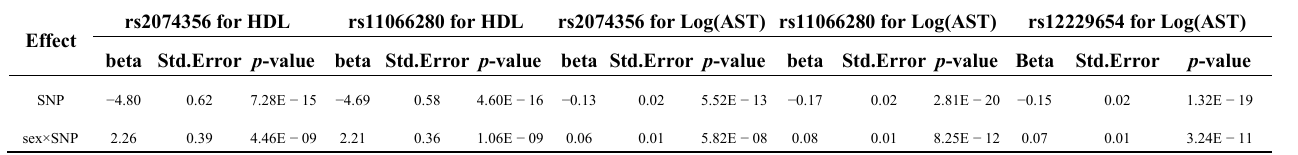
Table 8. Gene × environment interaction effect in the KARE cohort. Interactions of sex with SNPs were tested, and p -values for SNPs with genome-wide significant interaction are listed.